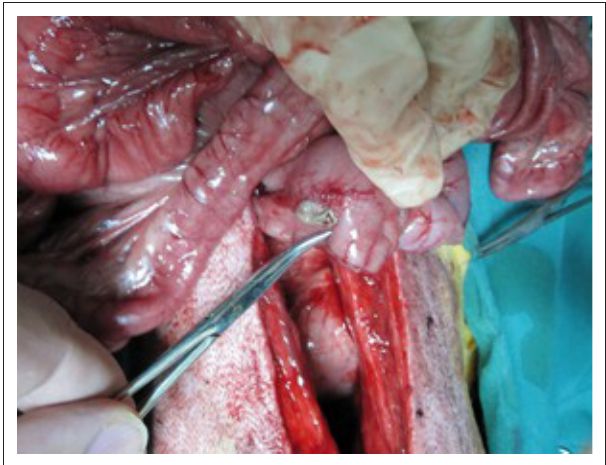
FIGURE 1: An unusual mass in the subserosal layer of the proximal part of the jejunum.